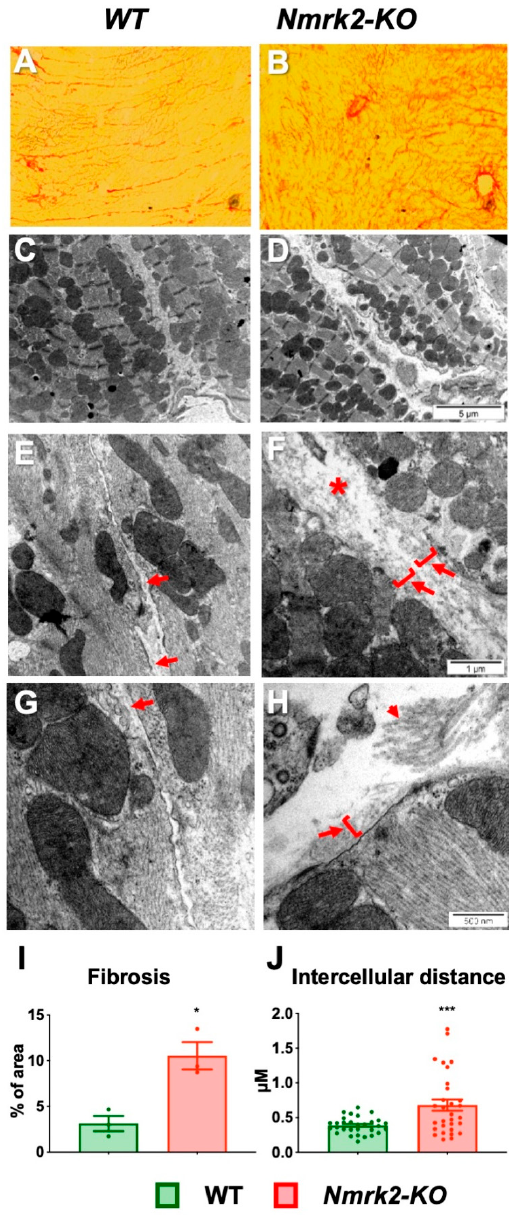
Figure 7. Histological analysis and ultrastructural analysis of cardiac muscle. Heart sections from 12 month-old controls ( A ) and mutant ( B ) were stained with Sirius red. Note the increase of collagen fibers in the region of the atrioventricular junction of the left ventricle in the mutant. Bar = 100 µm. ( E – H ) Electron microscopy of heart sections from 12 months-old controls ( C , E , G ) and mutants ( D , F , H ) at different magnifications. Asterisks in F highlights the wide extracellular space separating cardiomyocytes in Nmrk2-KO heart sections. Arrows point to the thin basal lamina that run along the plasma membrane in controls ( E , G ) while the basal lamina is poorly defined in the Nmrk2-KO ( F , H ) and intermixed with amorphous extracellular matrix spreading away from the sarcolemma (arrows and brackets). Small arrow in H points to large collagen bundles observed in Nmrk2-KO sections but not in controls. From A to H, pictures are representative of n = 3 mice/group (I) Quantification of red Sirius staining expressed as fractional area of the tissue section. Mean value for each individual are plotted ( n = 3 for each group). Bar graph represents de fold change over mean control value +/- SEM. ( J ) Quantification of the mean distance between cardiomyocytes. Technical replicates ( n = 30) were obtained from n = 3 mice/group. Data are expressed as the mean minimum diameter of fitting ellipses between cardiomyocytes +/- SEM. ( I , J ) t-test. *, p < 0.05; ***, p ≤